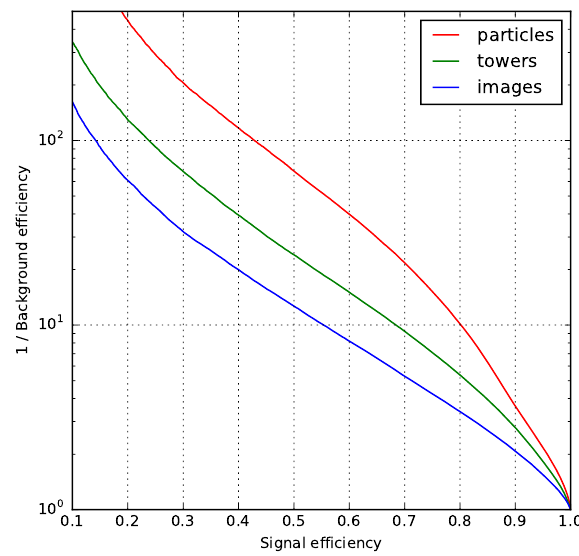
Figure 3 . Jet classi(cid:12)cation performance for various input representations of the RNN classi(cid:12)er, using k t topologies for the embedding. The plot shows that there is signi(cid:12)cant improvement from removing the image processing step and that signi(cid:12)cant gains can be made with more accurate measurements of the